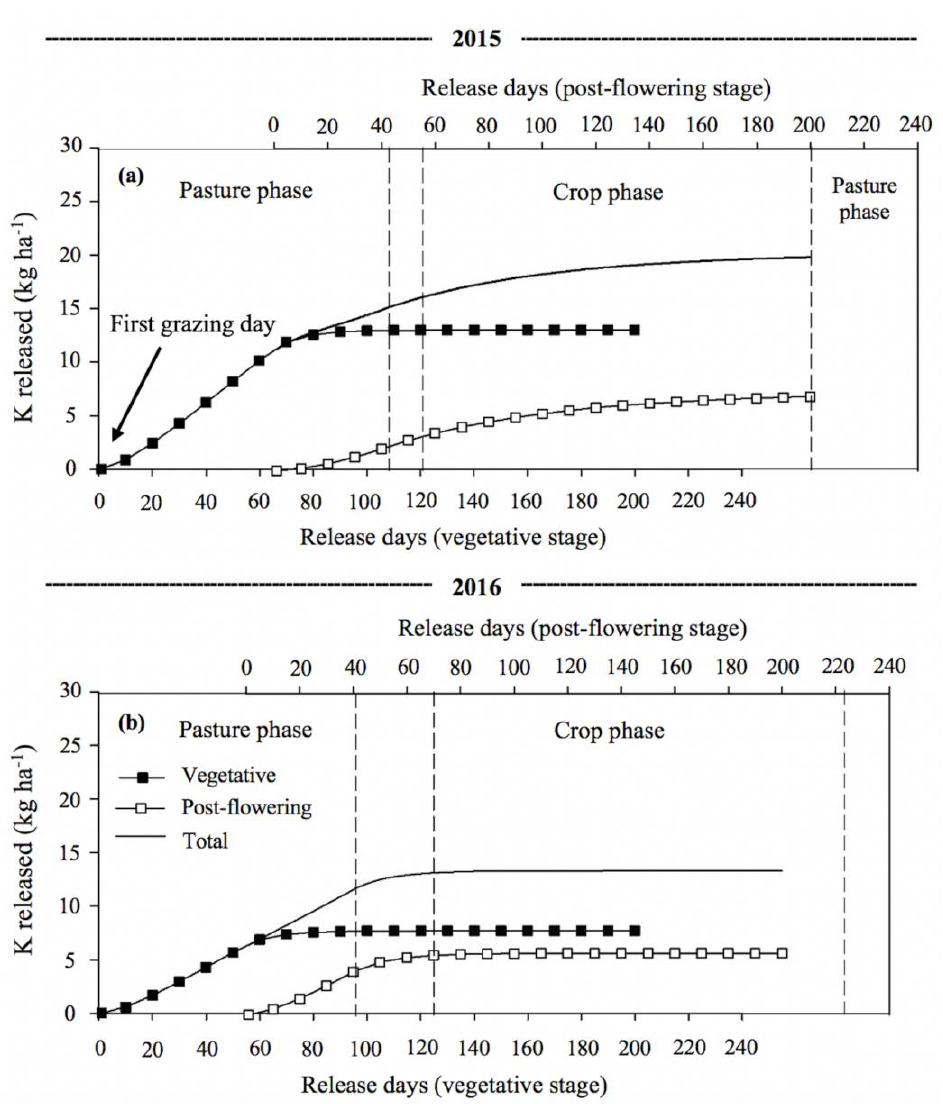
Figure 3. Accumulated phosphorus (K) release from sheep dung sampled at different pasture development stages (vegetative and post-flowering stages) and total accumulated P release over 2015 ( a ) and 2016 ( b ) annual cycles of a no-till integrated soybean-sheep production system (average of low and moderate grazing intensities).